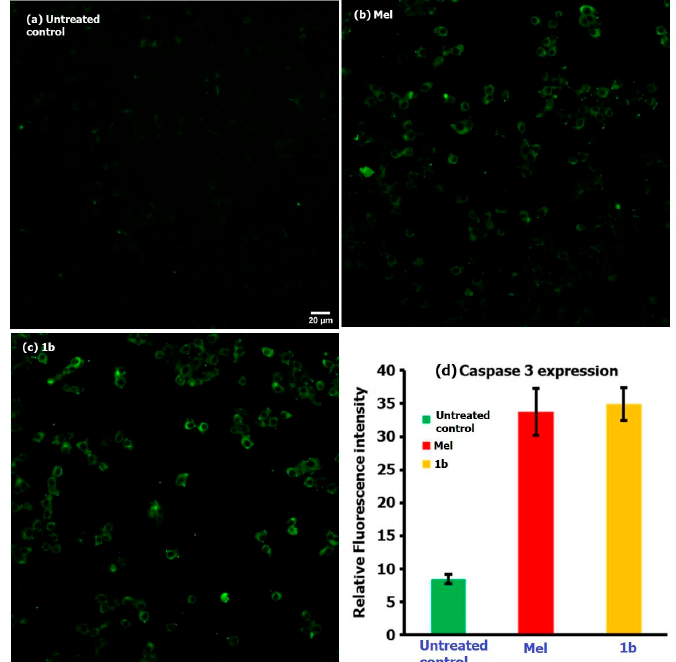
Figure 7. Caspase 3 activity comparison of HepG2 cancer cells, followed by the treatment of IC 50 concentration of compound 1b ( c ) with that of positive control of Mel (15 μ g/mL) ( b ) and negative control ( a ) over a 48 h period. Relative fluorescence intensity of all the samples is compared in ( d ).